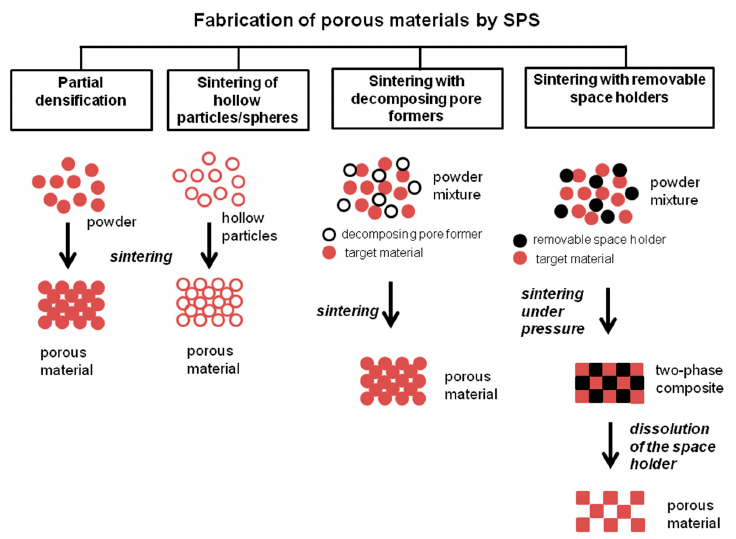
Figure 1. Approaches to the fabrication of porous materials by SPS.